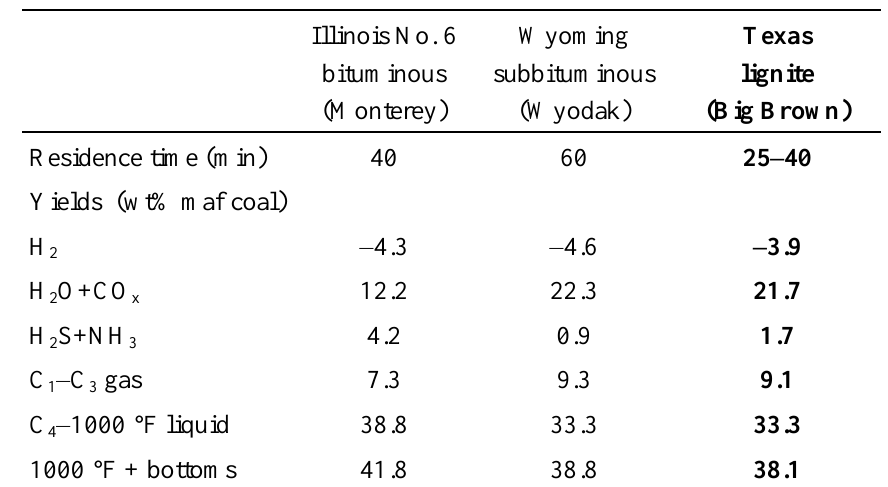
Table 10. Product yields of EDS process (2,500 psig, 840